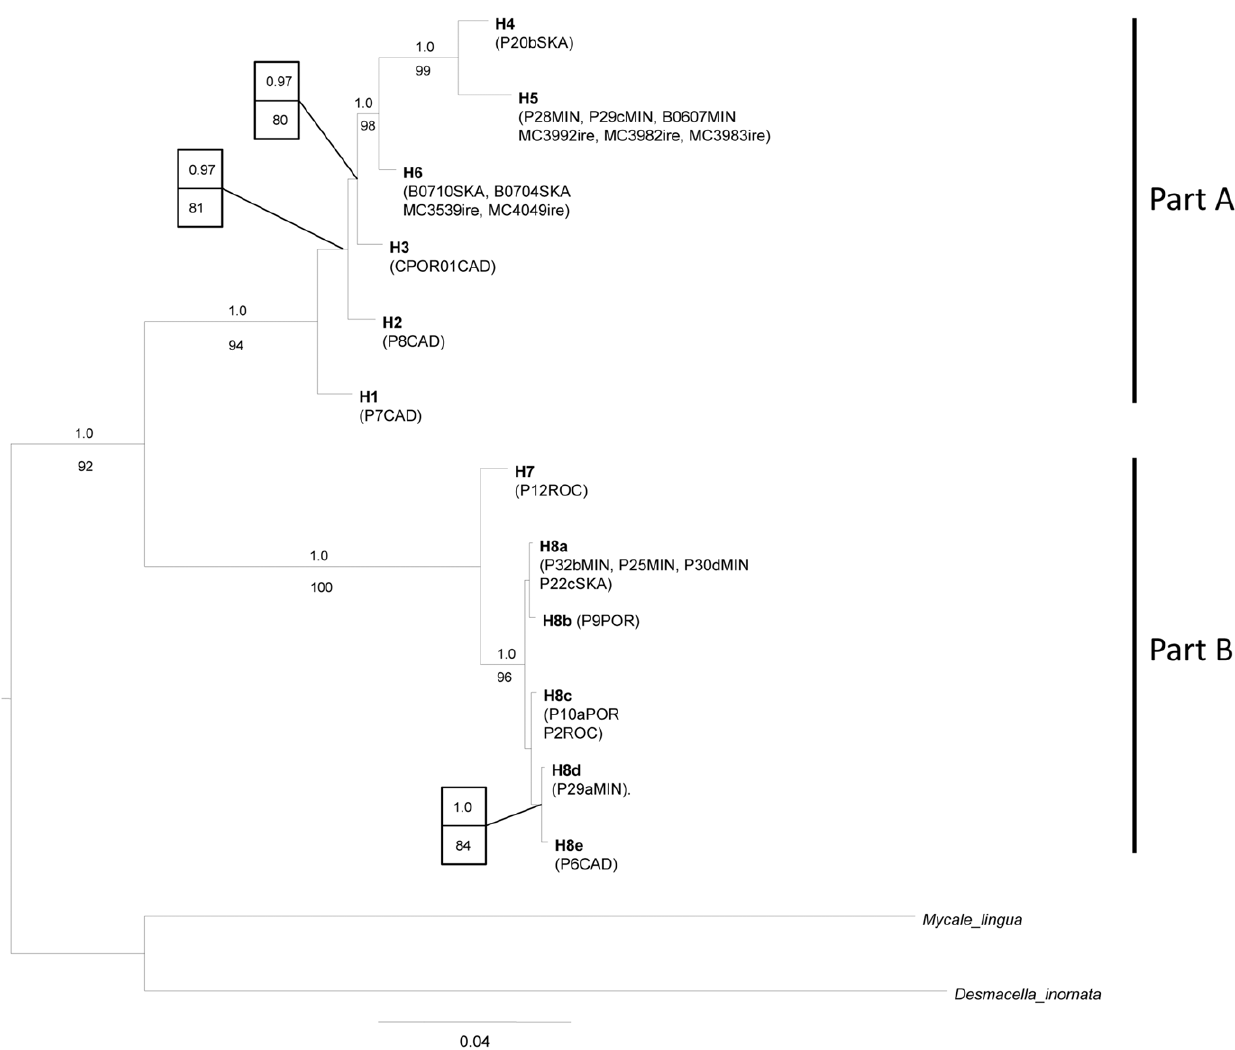
Figure 4. Bayesian majority-rule consensus tree of the concatenated dataset (COI-28S). Bayesian posterior probabilities (when . 0.95) and the ML bootstrap values (when . 70) are indicated above and below branches, respectively. For information on the specimens (listed in parenthesis) see Table S1. doi:10.1371/journal.pone.0016533.g004 PLoS ONE |